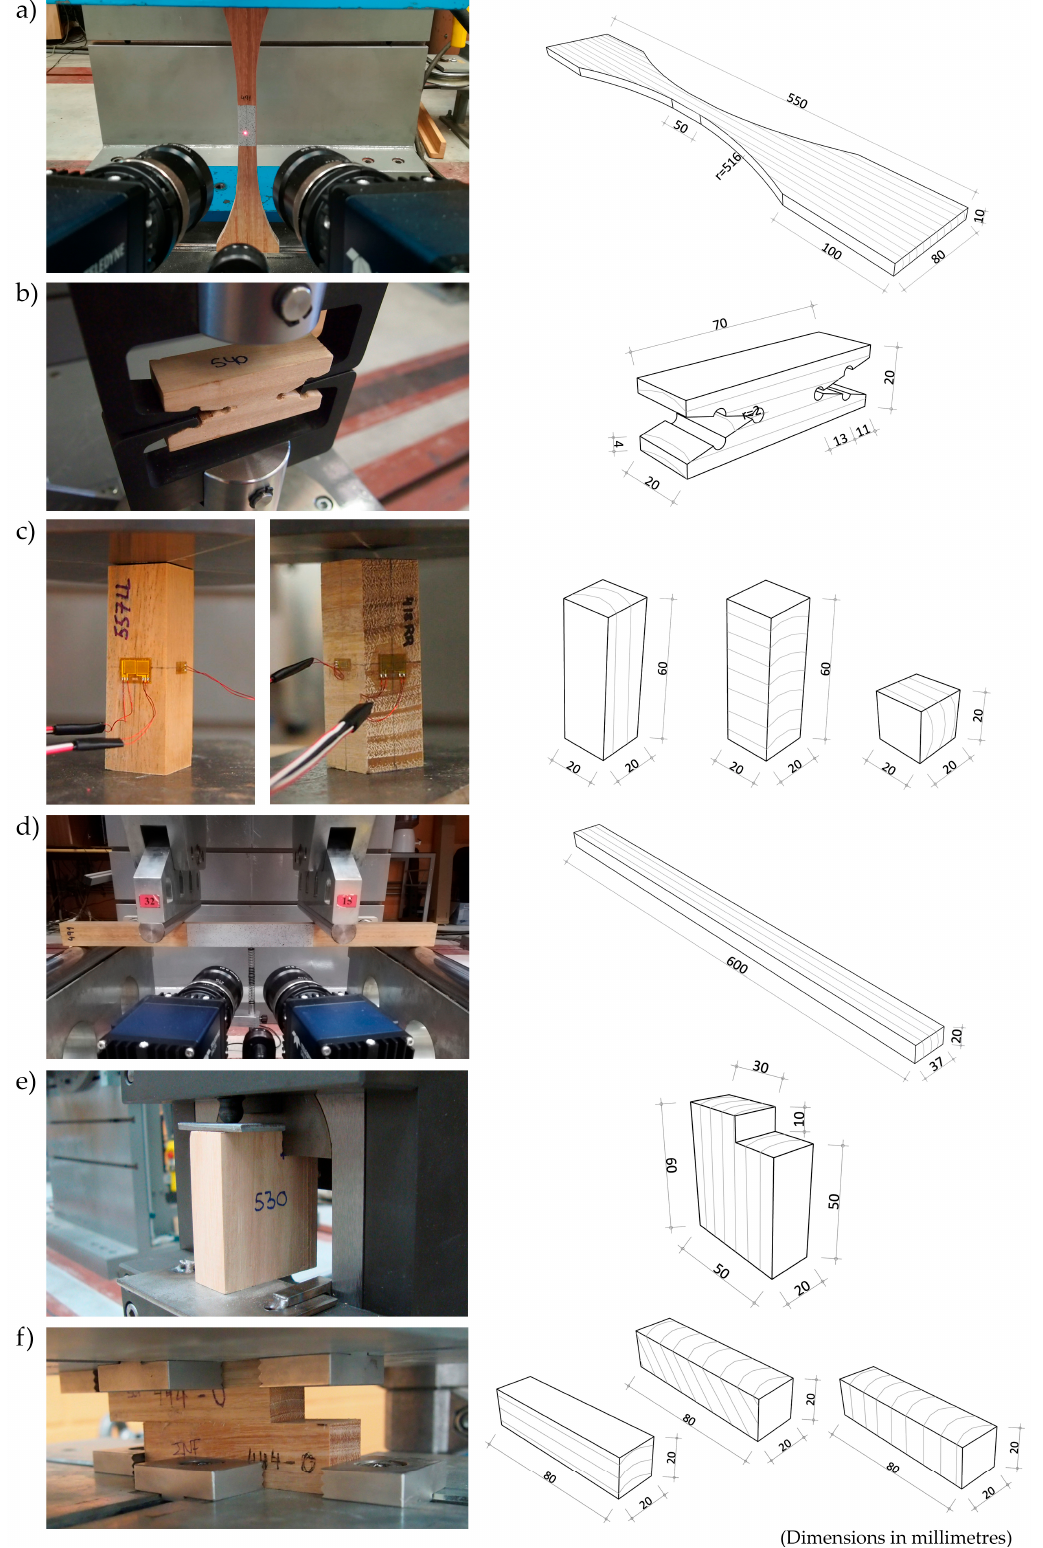
Figure 1. Test setup (left column) and specimen geometry (right column): ( a ) tension parallel to grain; ( b ) tension perpendicular to grain; ( c ) compression parallel and perpendicular to grain; ( d ) static bending; ( e ) shear; ( f ) timber-to-timber static friction.